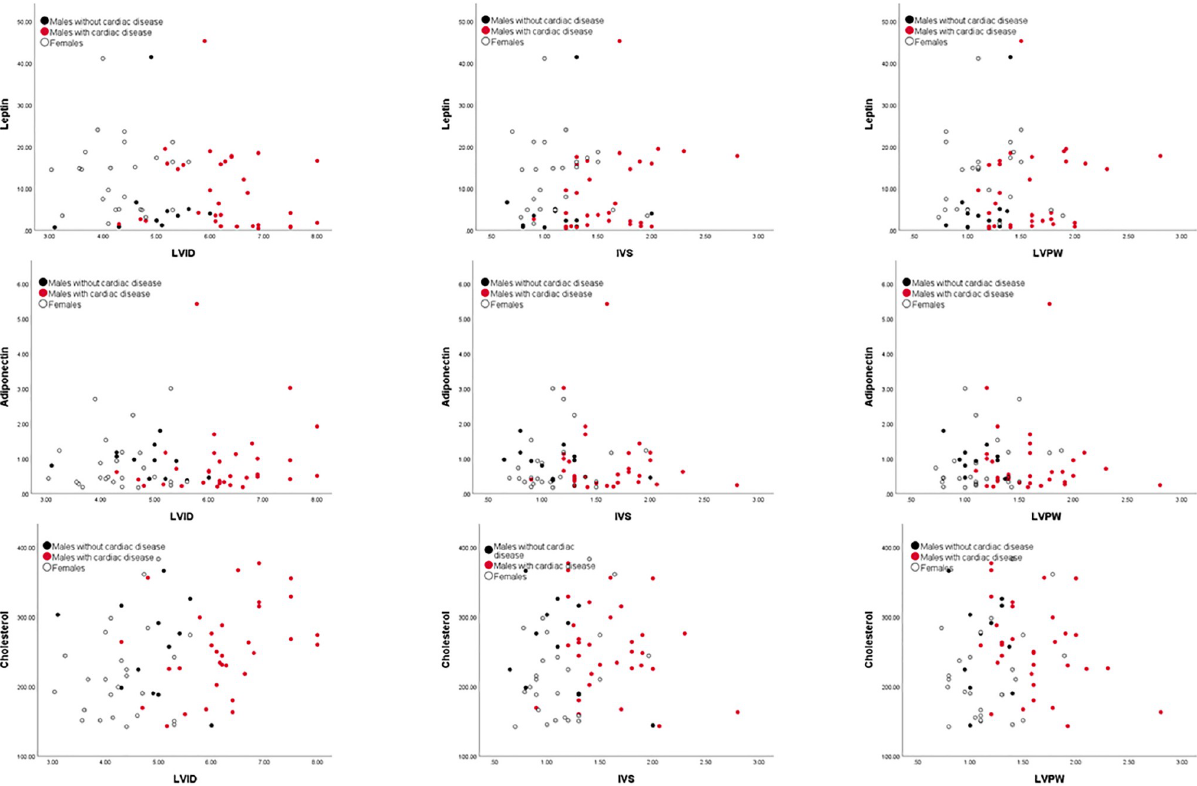
Fig 1. The significant variables for principal component 1 plotted against heart measures. Leptin, adiponectin and cholesterol are each plotted against heart measures LVID, IVS, and LVPW. For males, principal component 1 was significantly correlated with heart measures IVS and LVPW. Males that were previously diagnosed with heart disease are indicated by red circles, healthy males are depicted by black circles and females by white